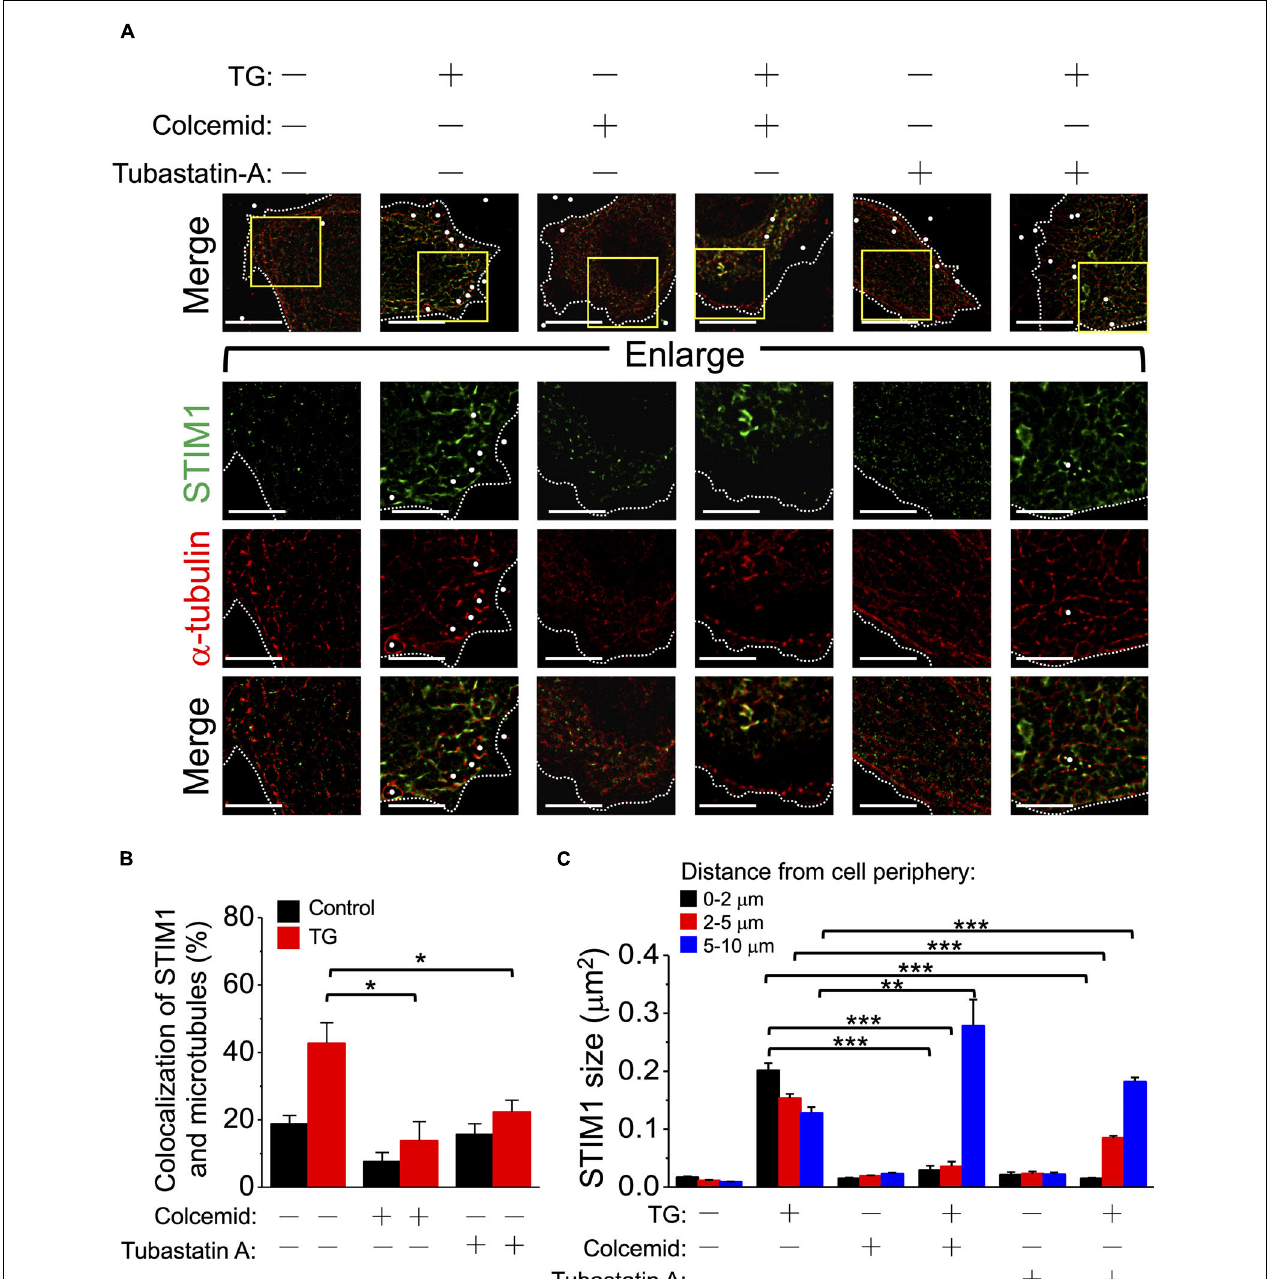
FIGURE 4 | Tubastatin A and colcemid block STIM1 membrane trafficking but not STIM1 aggregation. (A) SiHa cells overexpressing EGFP-STIM1 were preincubated with 0.1% dimethyl sulfoxide for 5 h, 5 µ M tubastatin A for 5 h, or 5 µ g/mL colcemid for 30 min before TG (2 µ M, 10 min) stimulation. Lower panels showing the enlargement of the areas indicated by rectangles in whole-cell images. Dashed line, cell periphery. White dots, TetraSpeck microspheres. Scale bar, 10 µ m. (B) The co-localization ratio of STIM1 and microtubules at the juxta-plasma membrane area were quantified by pixel-by-pixel analyses. Column, mean ± SEM from at least five cells of three independent experiments. * P < 0.05, compared with control group by one-way ANOVA with a Dunnett’s post hoc test. N.S., non-significant. (C) The molecular sizes of STIM1 using dSTORM imaging were analyzed based on their distance from the cell periphery. Column, mean ± SEM from at least five cells of three independent experiments. ** P < 0.01, *** P < 0.001, compared with control group by one-way ANOVA with a Dunnett’s post hoc test.